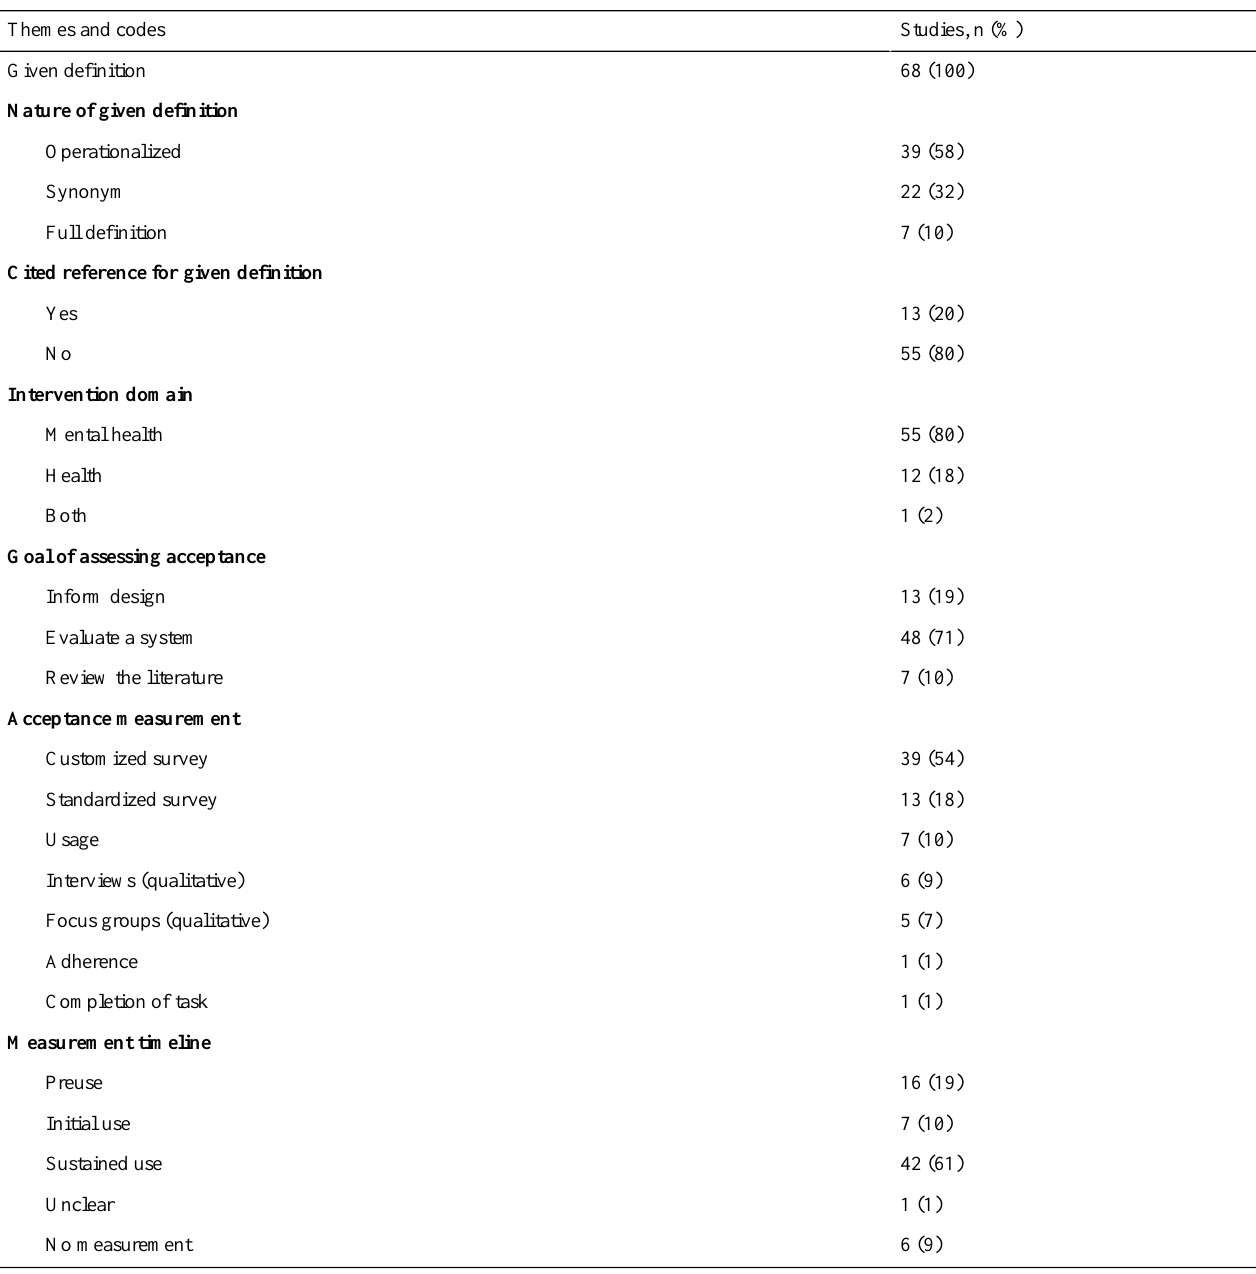
Table 1. Distribution of the main codes (some studies performed multiple measurements).